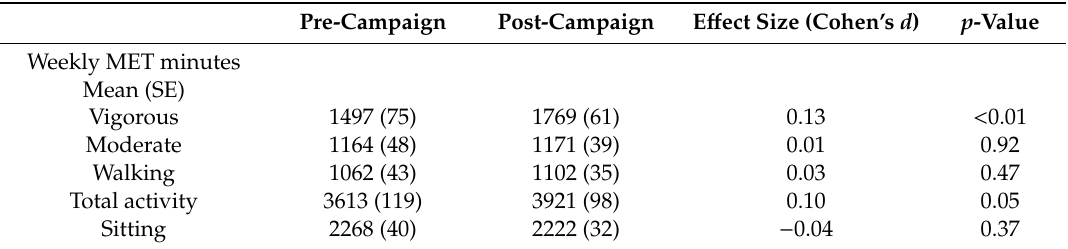
Post-Campaign Pre-Campaign Post-Campaign Compared to E ff ect Size p n (%) n (%) (Cohen’s h ) Pre-Campaign OR (95% CI)